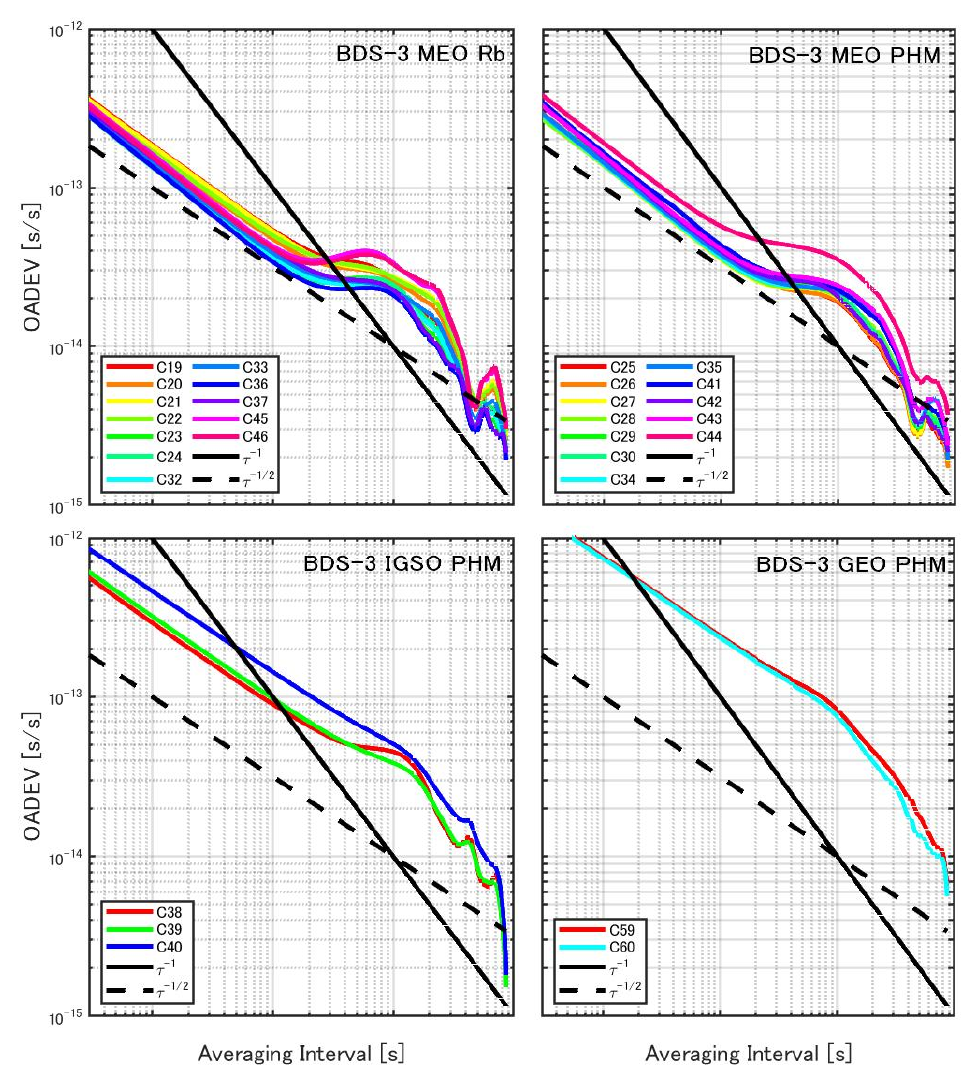
Figure 10. Clock offsets OADEV comparison of different BDS-3 clocks.